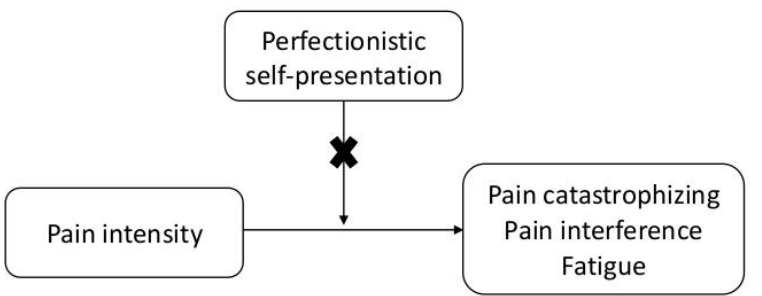
Figure 6. Moderating role for perfectionistic self-presentation in the association between pain intensity and pain catastrophizing, pain interference, and fatigue. This is, to the best of our knowledge, the first study that tested the potential moder- ating role of perfectionistic self-presentation in the associations between pain intensity and the three pain-related criterion variables studied here (i.e., pain catastrophizing, pain interference, and fatigue). If these findings are replicated in other samples, they would